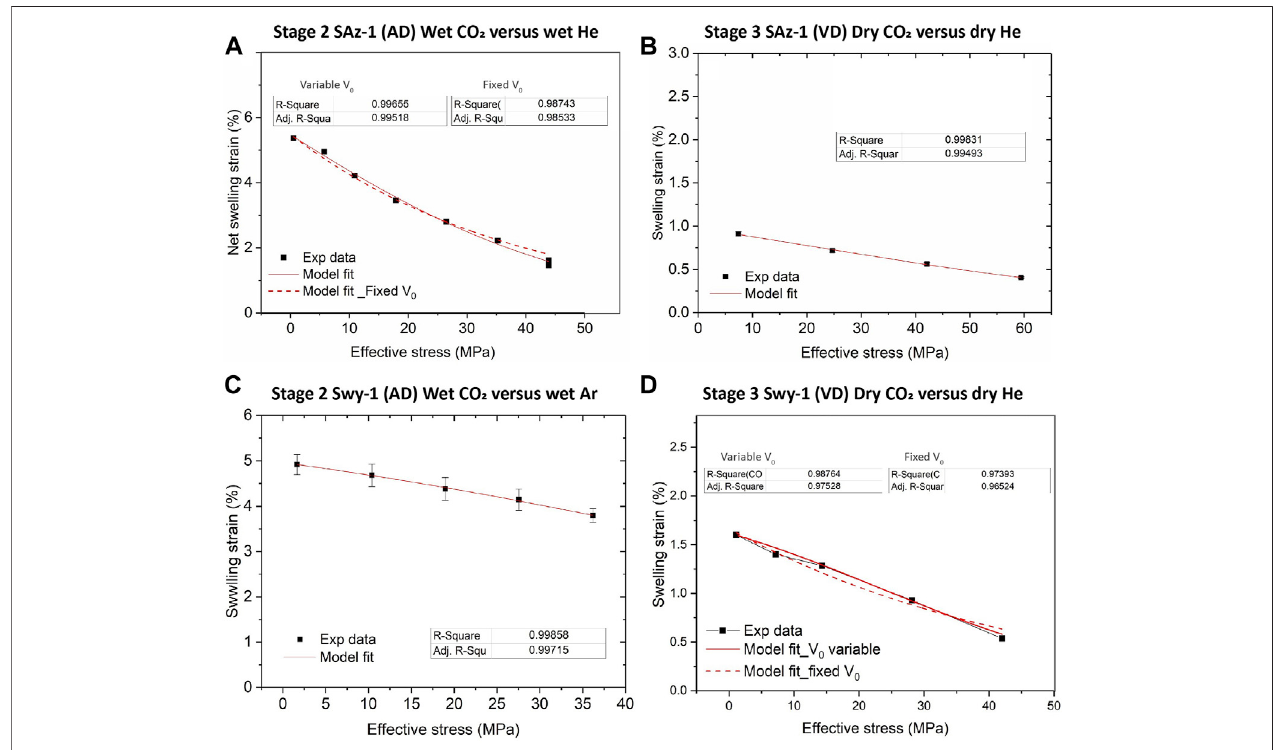
FIGURE 9 | Experimentally derived data on relative swelling strain as a function of applied stress, as obtained for CO 2 versus He and/or Ar in the Stage 2 (wet) and Stage3(dry)tests.Model fi tsusing Eq.2 areadded(redcurves)forcomparison. (A) Stage2datafortheinitiallyADCa-SAz-1sample. (B) Stage3datafortheVDSAz-1 sample. (C) Stage 2 data for the initially AD Na-SWy-1 sample. (D) Stage 3 data for the VD Na-SWy-1 sample.